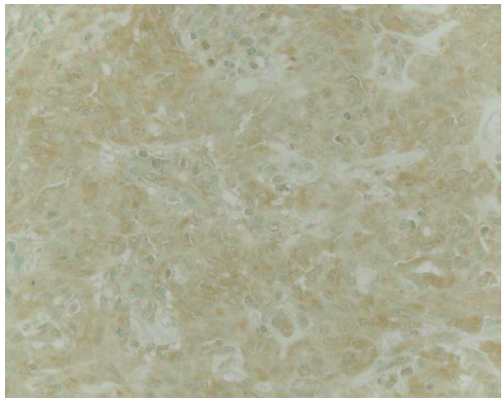
Figure 8: Showing p53 negative control for CPA. Original magnifi- cation